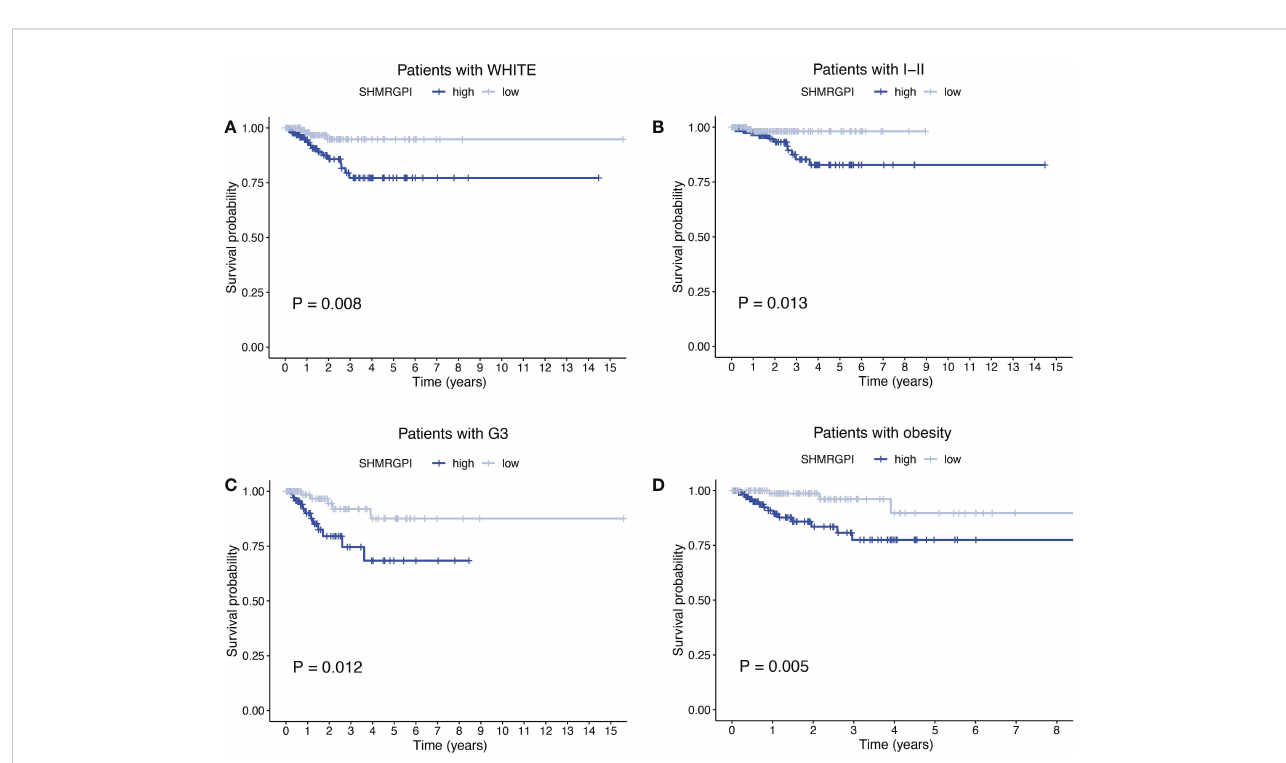
FIGURE 5 Strati fi ed analysis of EEC patients. Kaplan-Meier curves of patients with white race (A) , FIGO stage I-II (B) , tumor grade 3 (C) , BMI ≥ 30 (D) . FIGO, the international federation of gynecology and obstetrics. BMI, body mass